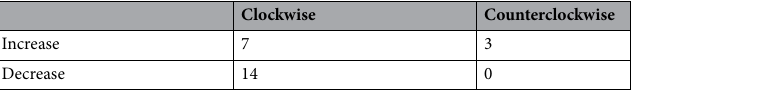
Table 1. Distribution of switching events for the 1 km long cavity. Out of 30 pump power cycles the cavity did not switch to a single direction 6 times.